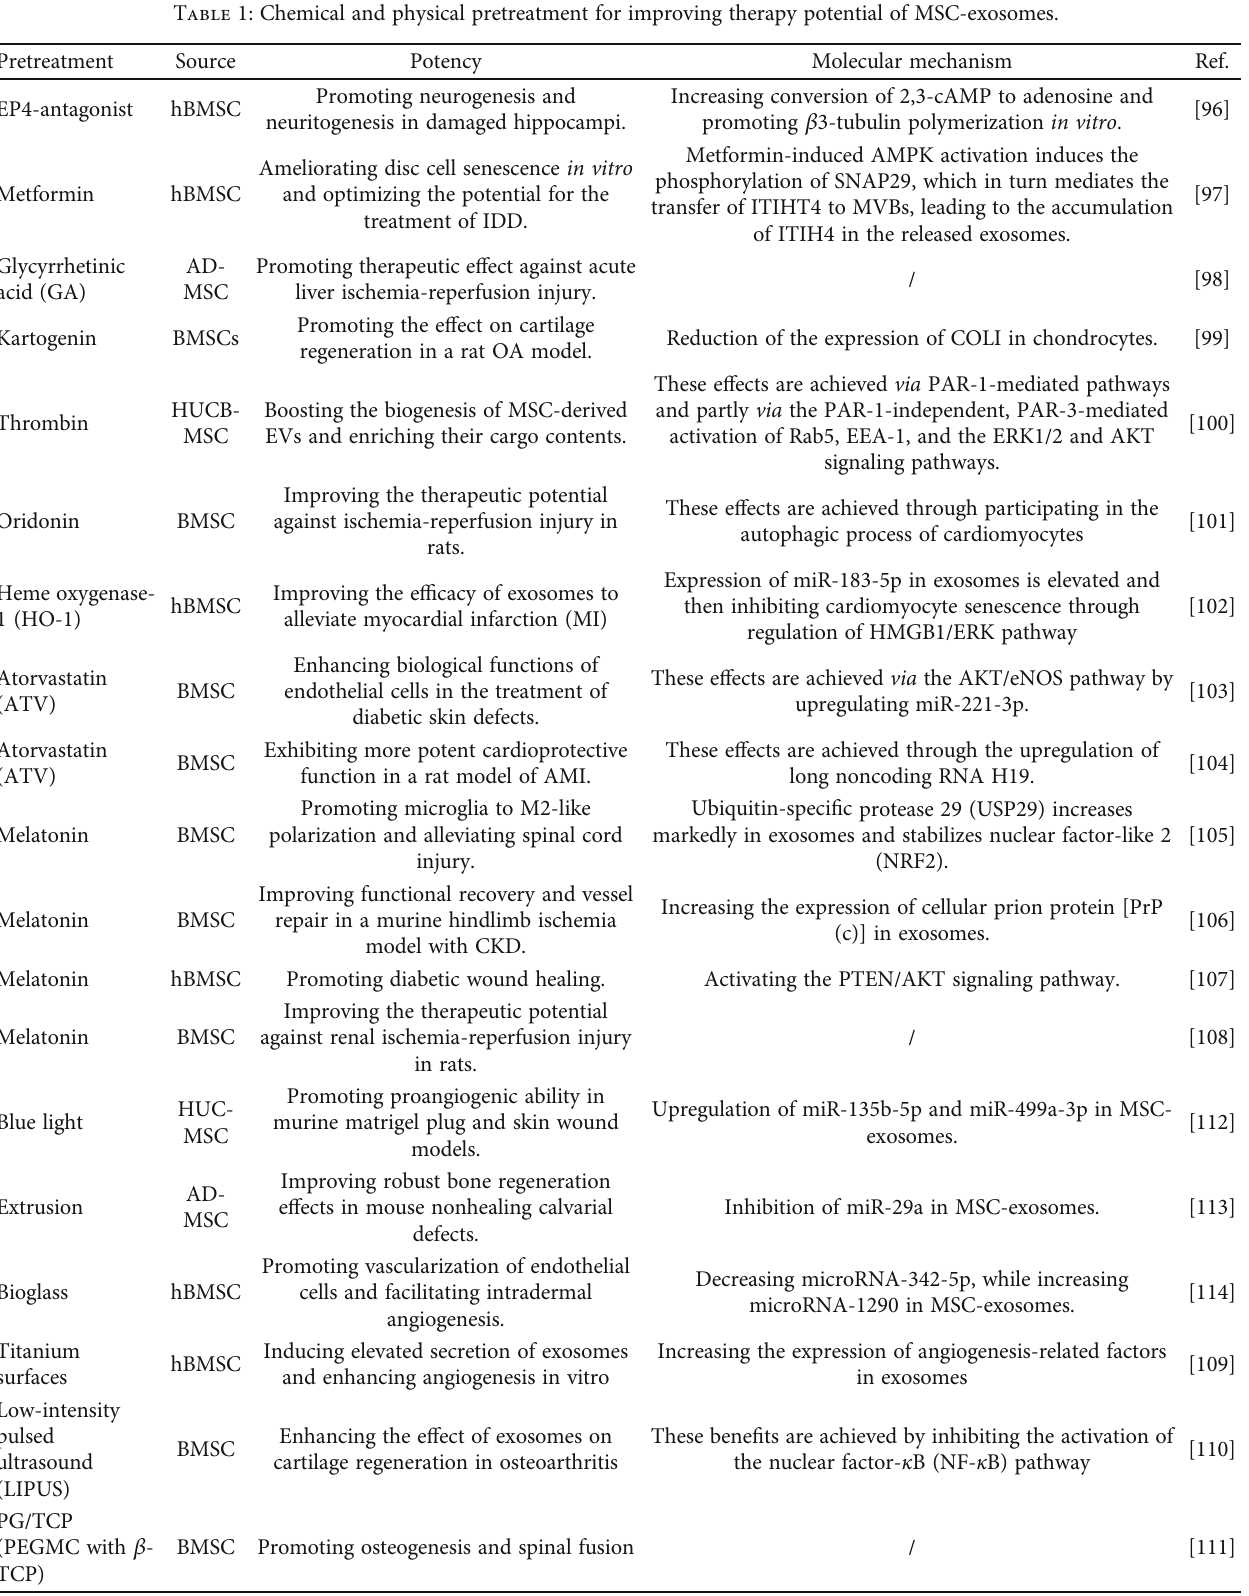
Table 1: Chemical and physical pretreatment for improving therapy potential of